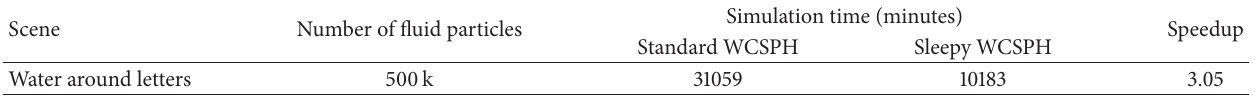
Table 1: Performance comparison of our method with standard WCSPH for Figure